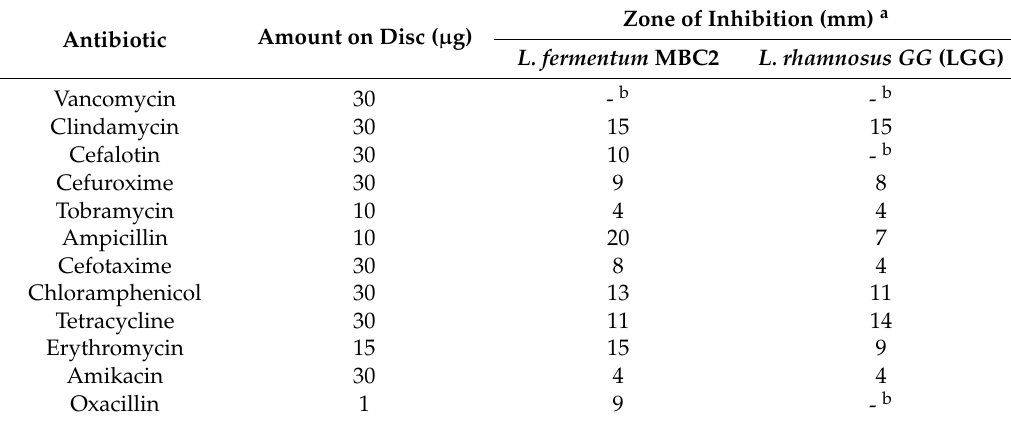
Figure 9. Adhesion to Caco-2 cells. Cell counts of viable L. fermentum MBC2 ( A ) and LGG ( B ) adhering on differentiated Caco-2 cells co-cultured with 1 × 10 8 ( a ) or 1 × 10 9 ( b ) bacterial colony forming units (CFU)/well. Grey columns refer to the initial bacterial load, while white columns refer to adhering bacteria recovered at the end of co-incubation. Data are reported as log of bacterial CFU recovered after plating. Columns represent the mean ± SD of two independent experiments, each performed in triplicate. Statistical analysis was performed by one-way ANOVA, followed by post-hoc Tukey honestly significant difference (HSD) test. Asterisks indicate significant differences (*** p < 0.001).